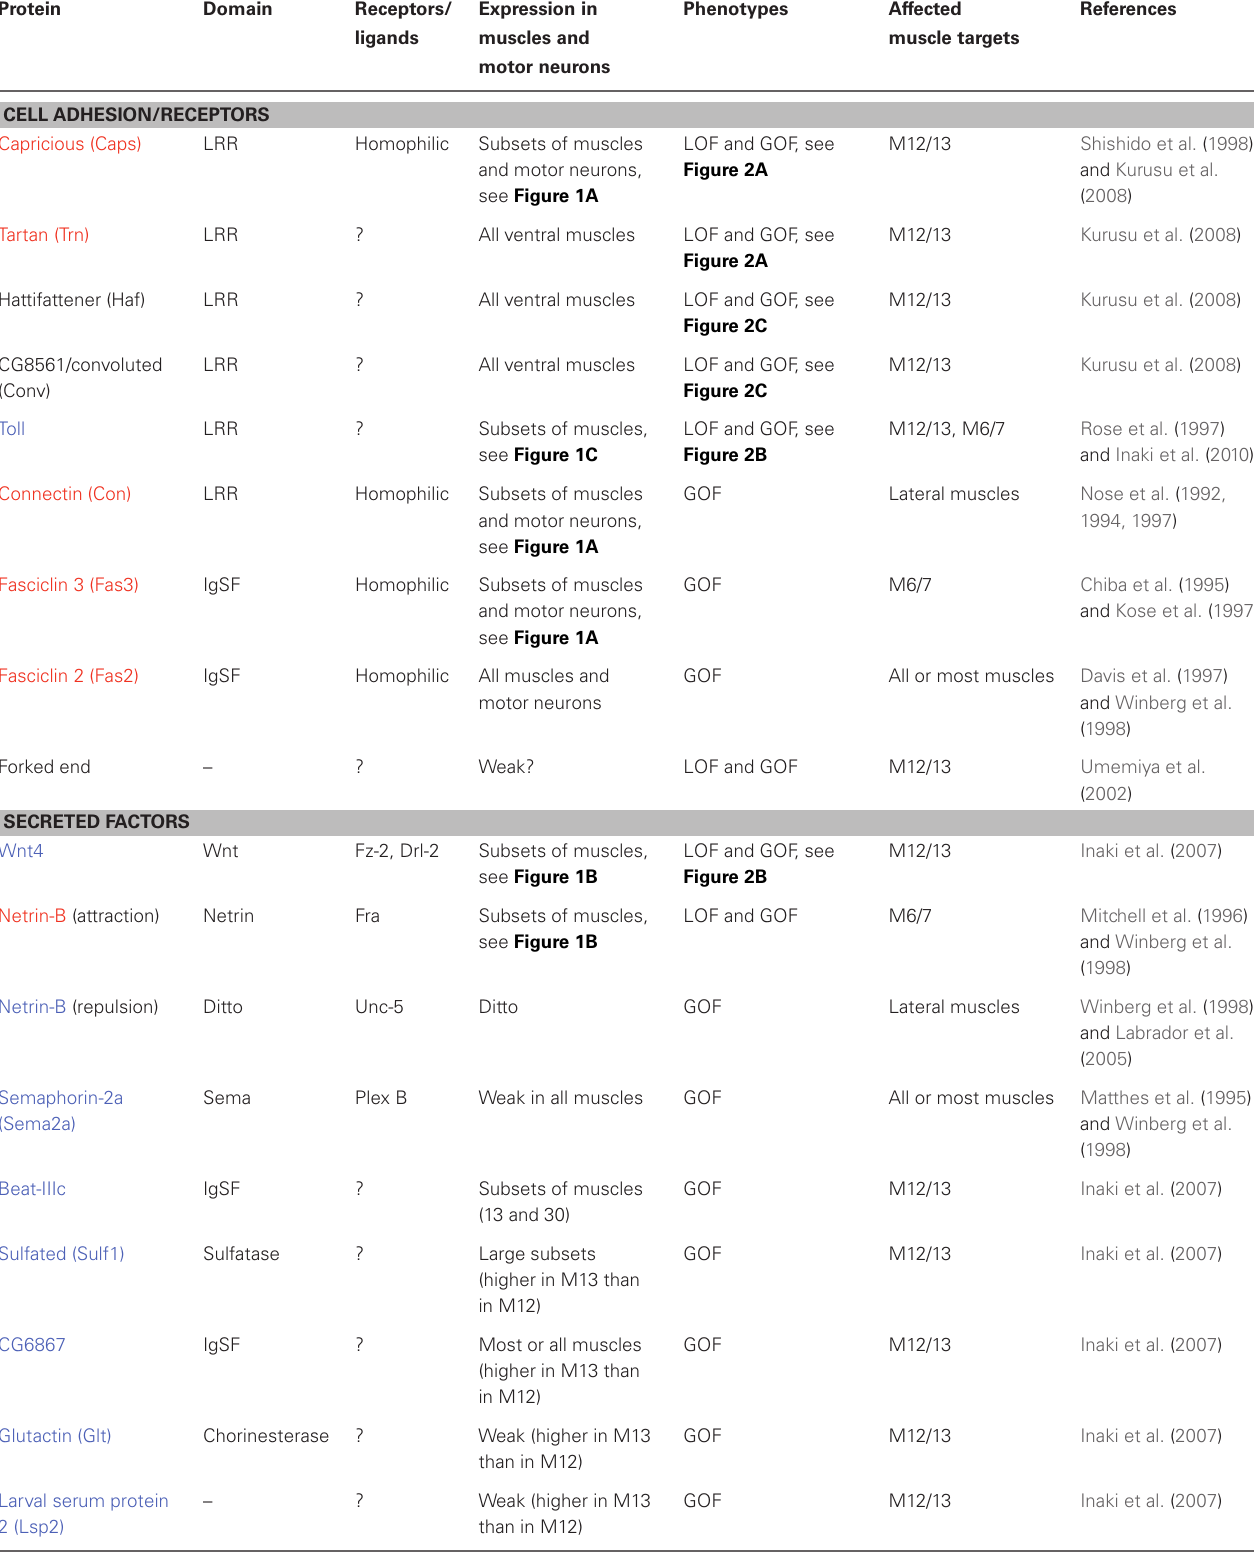
Attractive and inhibitory cues are shown in red and blue color,